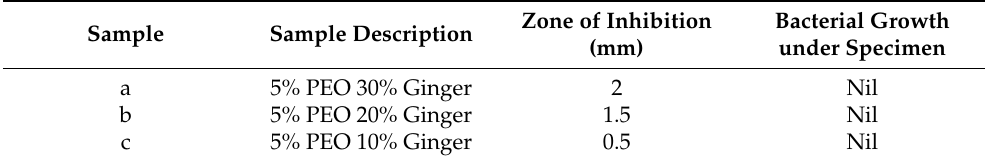
Table 3. Zone of inhibition of the PEO/GE nanomembrane.